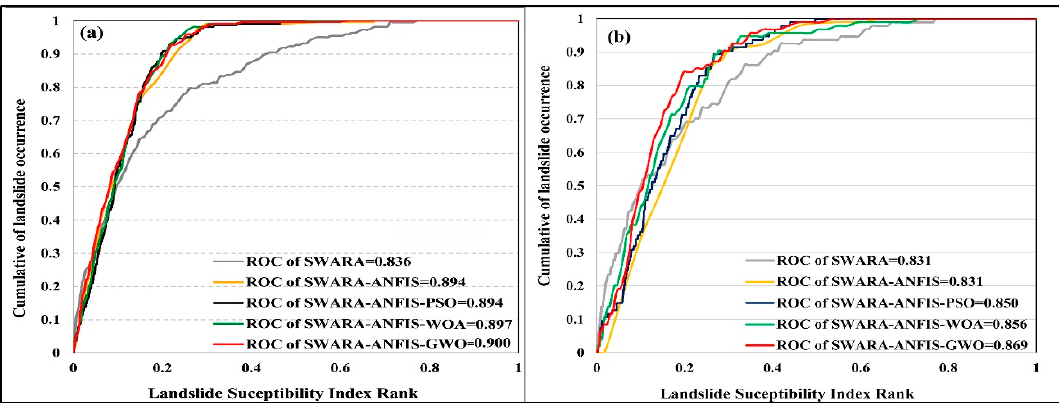
Figure 16. ROC curves for all methods using ( a ) the training dataset and ( b ) the verification dataset.